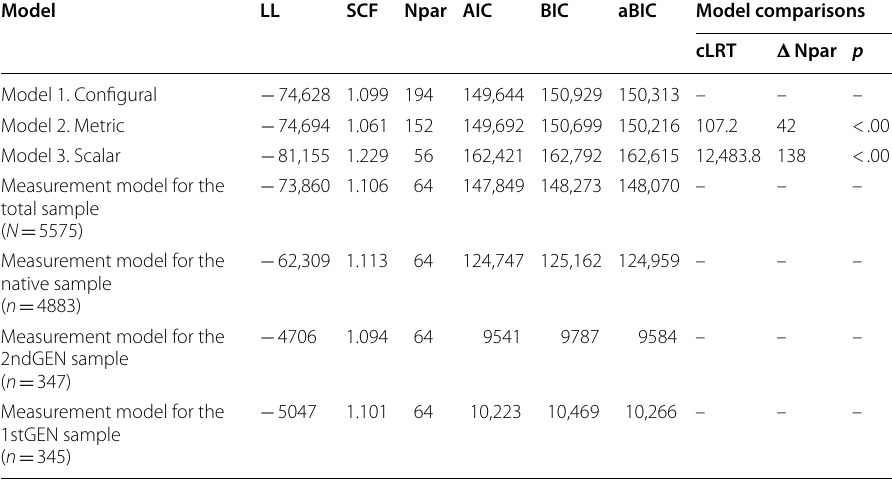
Table 4 Likelihood-ratio tests and information criteria of the multi-group invariance models for Norway